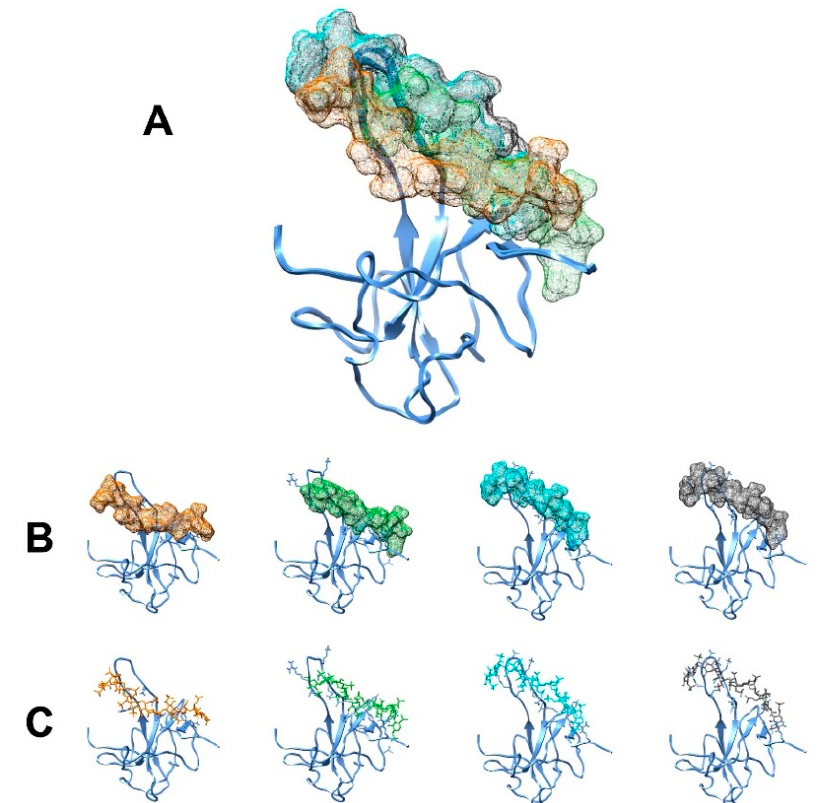
Figure 7. The results for the docking performed using HADDOCK are reported in the picture. The four structures derived from the best cluster are reported in Panels ( A , B ) in a superimposed and separate view, respectively. The protein structures are represented in the ribbon view while the mesh surface of EP is shown. The same four complexes with EP structure presented in stick view are displayed in Panel ( C ). Moreover, the side chains of NTD’s residues computed to be in close contact with EP are also shown in Panels B , C .